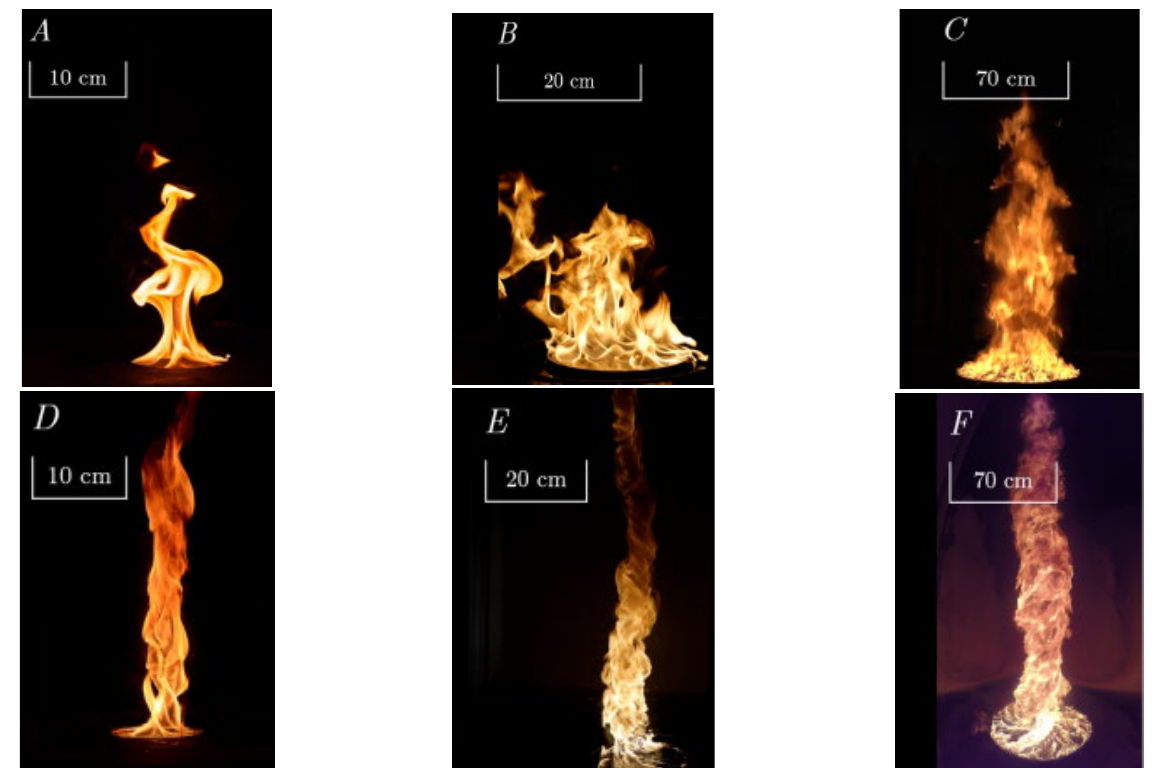
Figure 5. Instances of pool fire ( A – C ) and fire whirls (panels D – F ) constituted applying ANS crude oil [29].